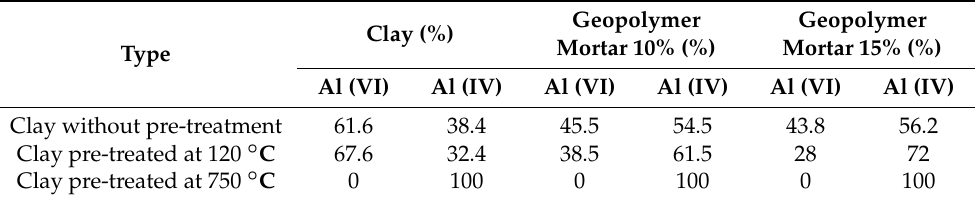
Table 5. Relative area and coordination of Al (VI) and Al (IV) of clay and alkali-activated mortar at 28 days (AM 1.0, dosages of 10% and